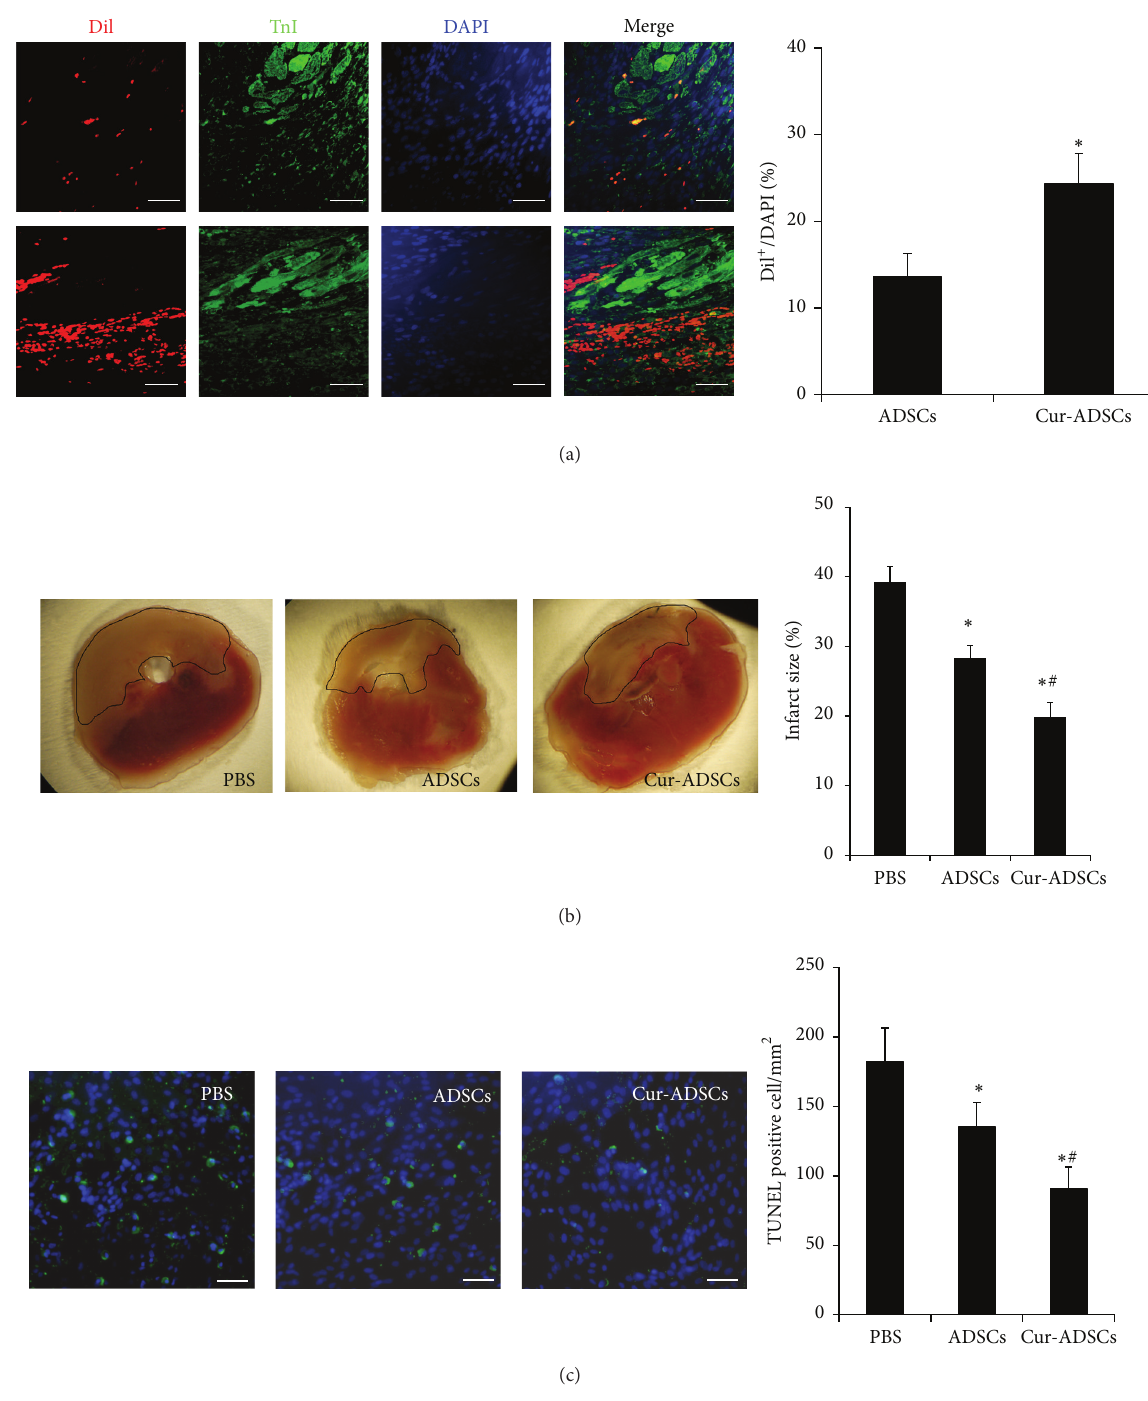
Figure 5: Administration of pretreated ADSCs increases cells retention and decreases myocardial fibrosis and apoptosis after myocardial infarction at 7 days after transplantation. (a) Representative fluorescence microscopic images ADSCs (Dil + , red florescence), cardiomyocytes (cTnI, green florescence), and DAPI (blue fluorescence) at 1 week after injection. Quantitative analysis revealed that a higher retention of ADSCs in Cur-ADSCs group was observed. Scale bars = 50 𝜇 m. ∗ 𝑃 < 0.05 versus ADSCs. (b) Effect of ADSCs transplantation and/or pretreatment with curcumin on infarct size. Representative TTC staining images and quantitative analysis at 7 days after transplantation showed intramyocardial injection of ADSCs decreased the LV infarct size ( 𝑃 < 0.05 ). Scale bars = 100 𝜇 m. Statistical differences ( 𝑃 < 0.05 ) are indicated from PBS ( ∗ ) and ADSCs (#). (c) Measurement of apoptosis in the ischemic heart. Representative TUNEL staining images in the peri-infarct area of heart slices by immunofluorescence and quantitative analysis showed TUNEL positive cells were the least in the Cur-ADSCs group ( 𝑃 < 0.05 ). Scale bars = 100 𝜇 m. Statistical differences ( 𝑃 < 0.05 ) are indicated from PBS ( ∗ ) and ADSCs